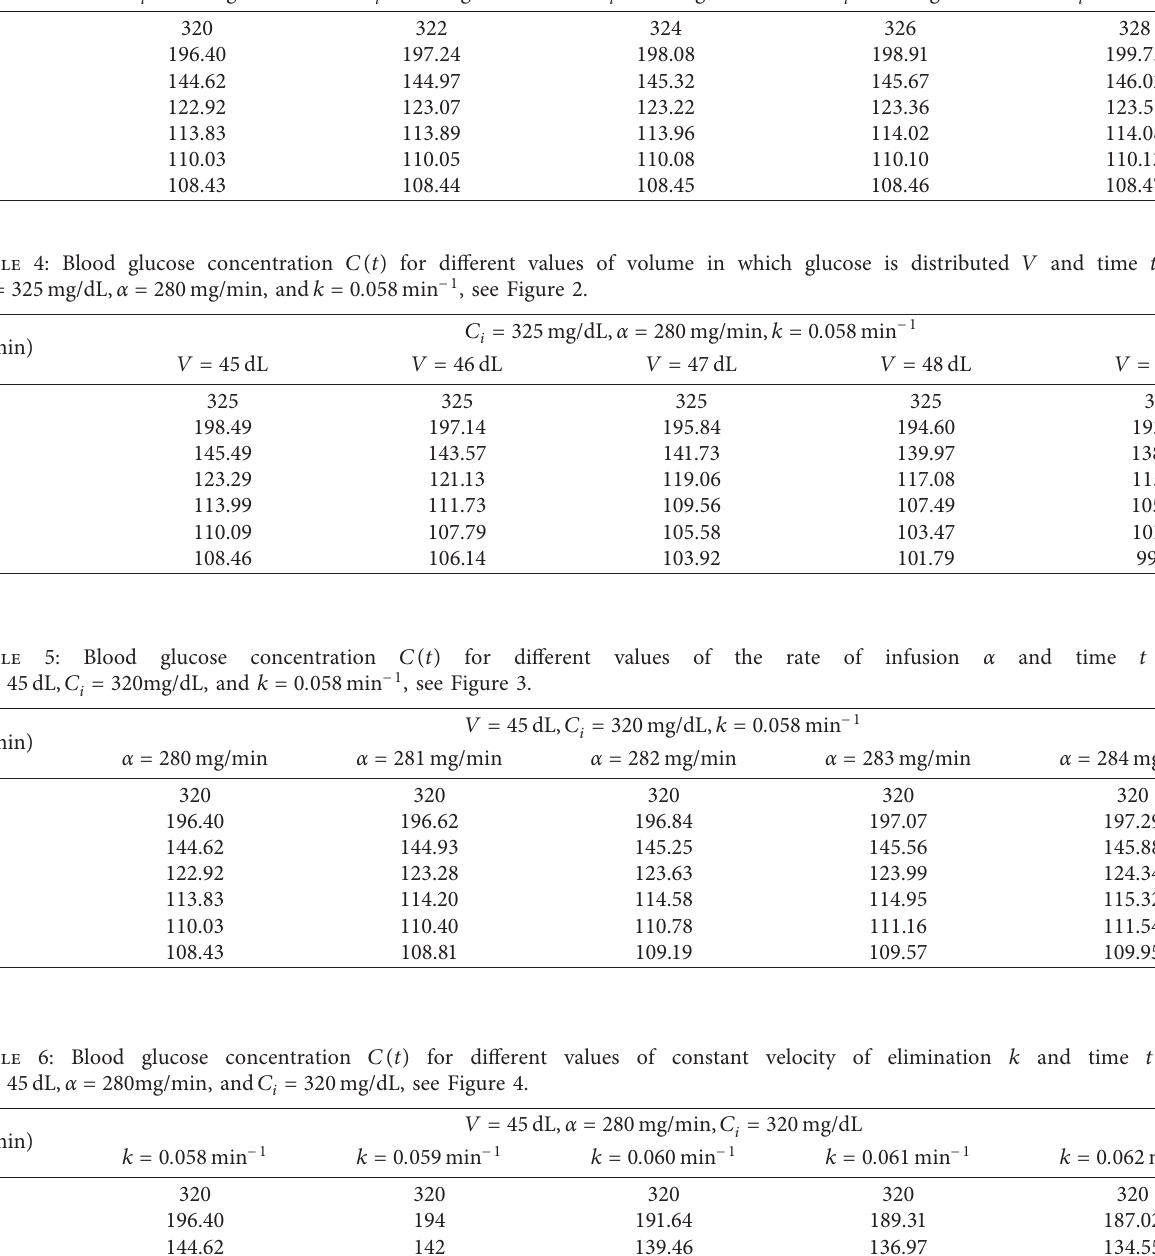
Table 3: Blood glucose concentration C ( t ) for different values of initial concentration of glucose C V � 45dL , α � 280mg/min , and k � 0 . 058 min − 1 , see Figure 1. t ( min )